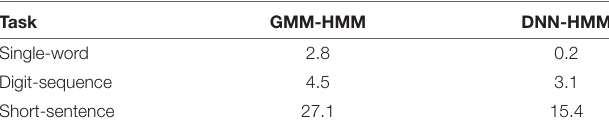
TABLE 1 | Word error rates